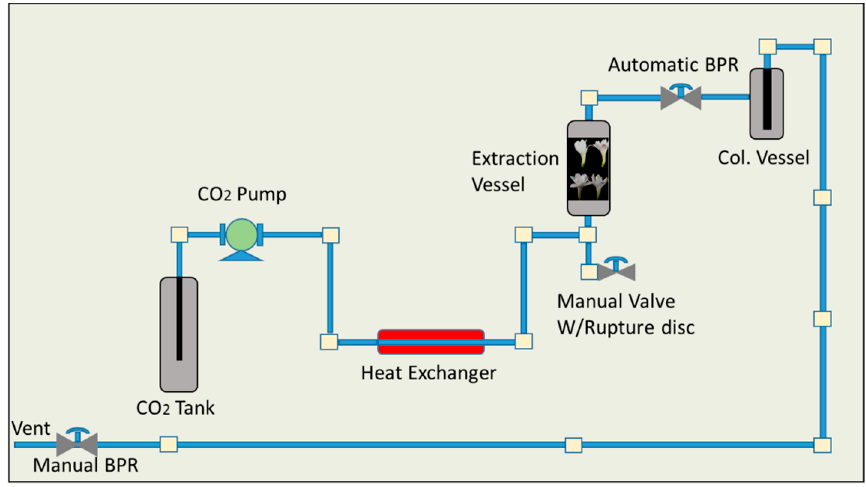
Figure 1. Diagram of the extraction process by supercritical CO 2.